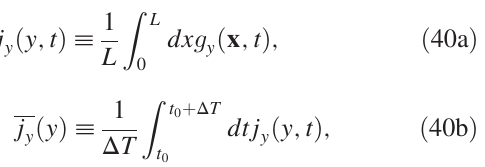
Fig. 7, the net rates _ n at which the left- and right-moving cluster lanes in Figs. 6(b) and 6(c) gain and lose particles are plotted as a function of time in the long-time regime λ t ∈ ½ 10 000 ; 20 000 (cid:2) , where the cluster-lane pattern is virtually stationary. Because of overall particle conserva- tion, the red and black curves in Fig. 7 sum up to 0. The net